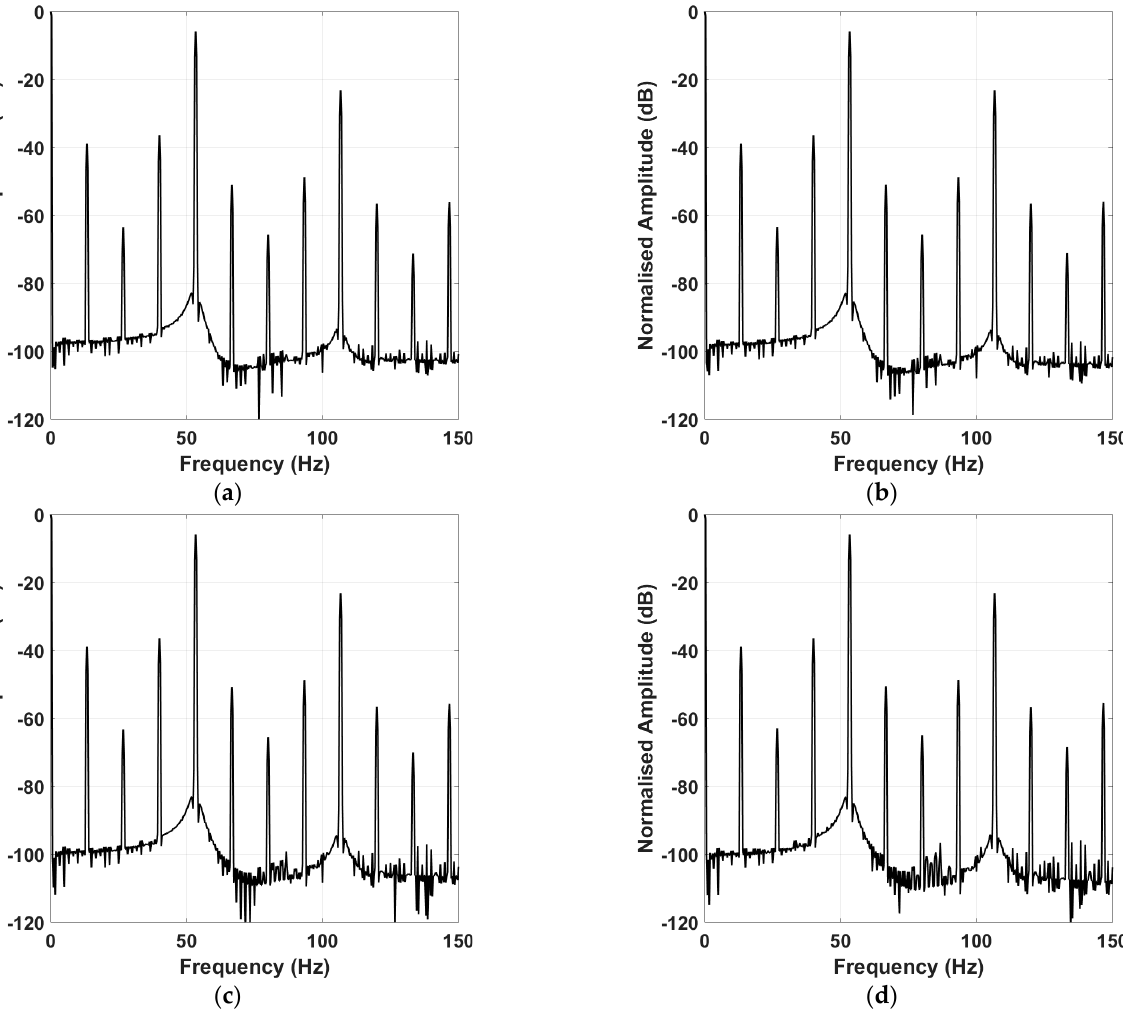
Figure A5. Simulation results. EPVA spectrum of the generator at 100 rpm: ( a ) Local demagnetization 5 kW; ( b ) Local demagnetization 4 kW; ( c ) Local demagnetization 2 kW; ( d ) Local demagnetization 1 kW.